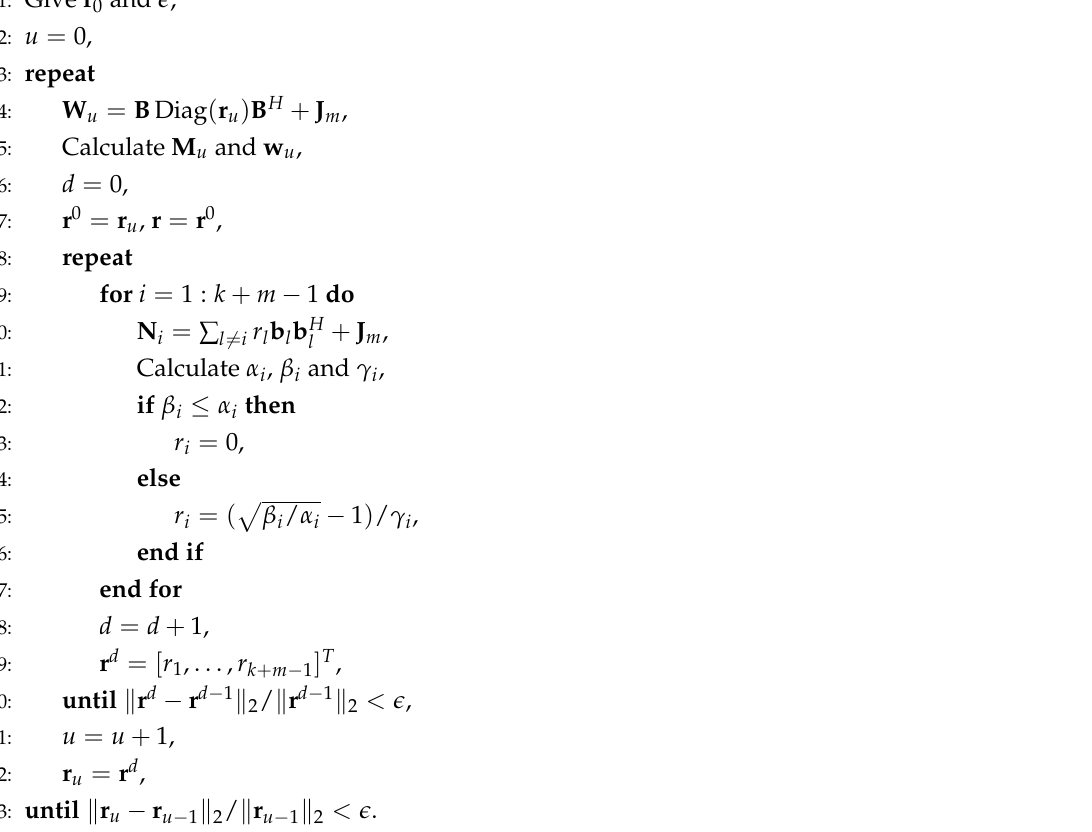
Algorithm 1 The MM1-CD algorithm for spatially non-uniform white